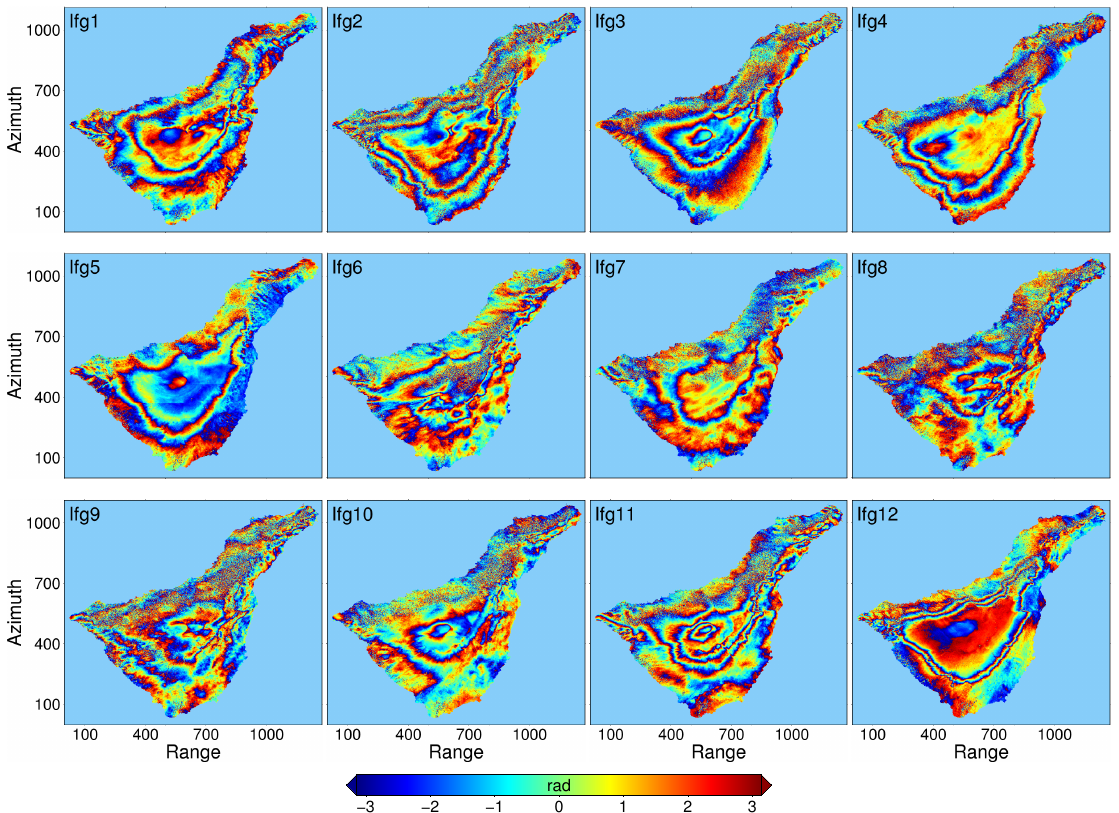
Figure 7. Original wrapped differential interferograms covering one entire year over Tenerife island, Spain. Each interferogram connects two consecutive months. Detailed temporal and spatial baselines information for each interferogram can be found in Table 1.